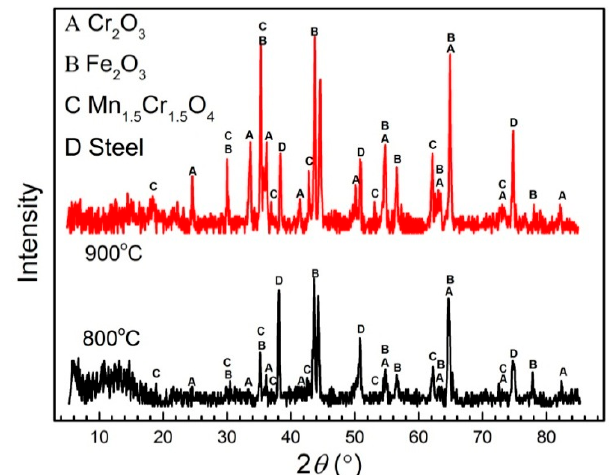
Figure 6. X-ray diffraction (XRD) patterns of oxidation film on the specimen surfaces after the thermal fatigue tests under different T max conditions: 800 and 900 °C.